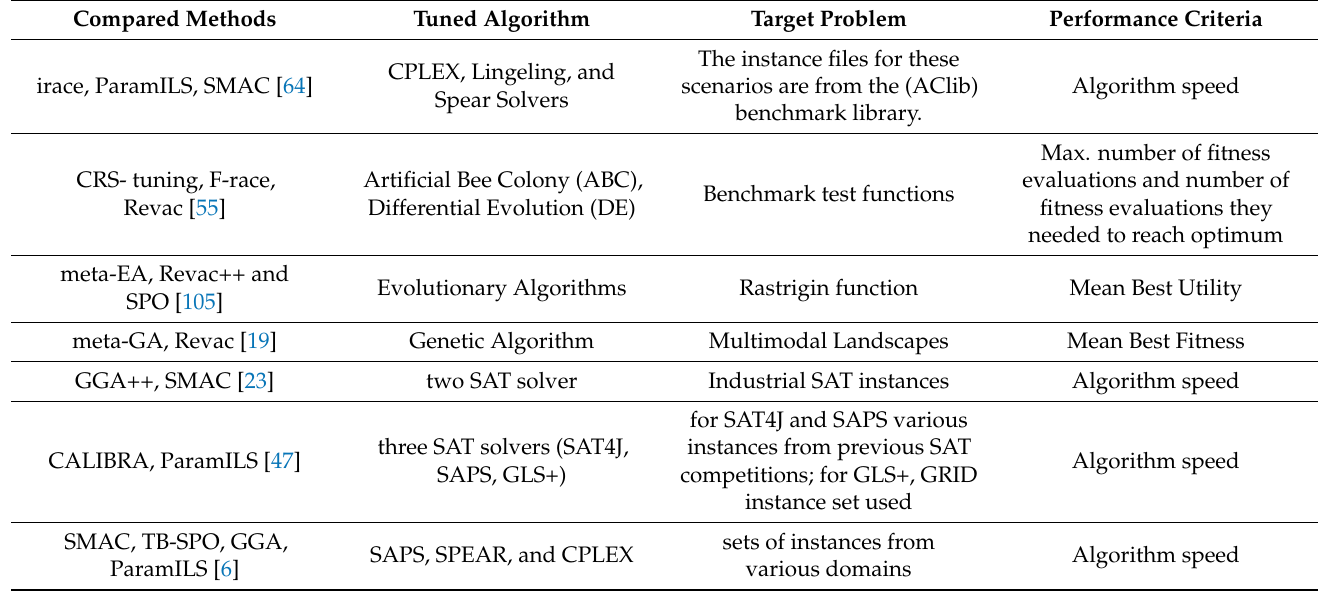
Table 4. List of papers that compare various algorithm configuration methods. Compared Methods Tuned